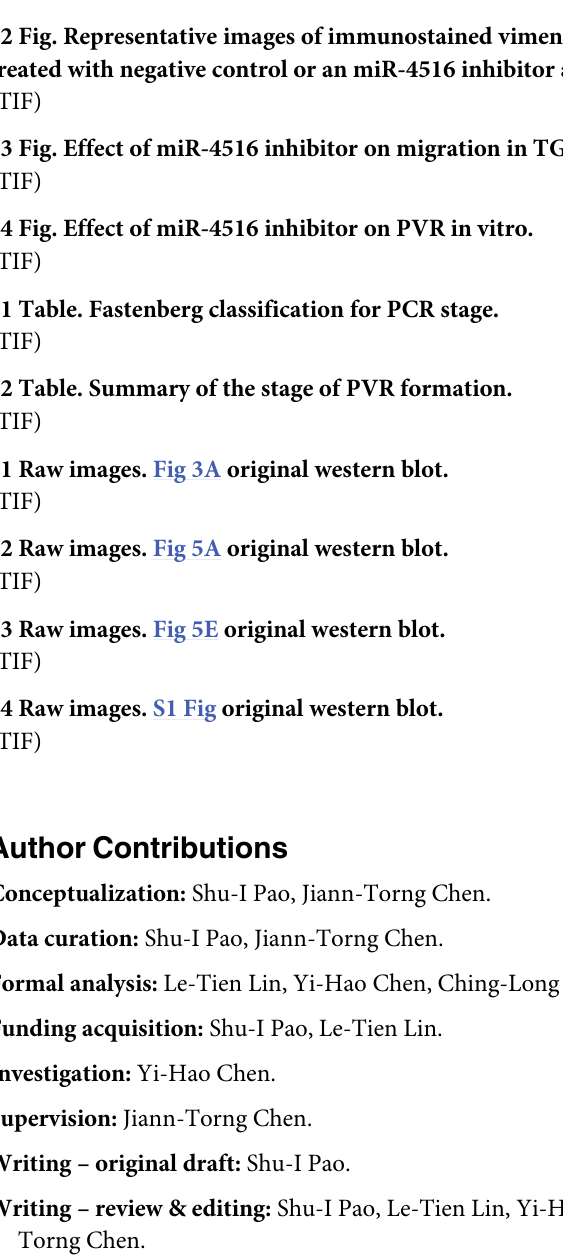
S2 Fig. Representative images of immunostained vimentin and ZO-1 in ARPE-19 cells treated with negative control or an miR-4516 inhibitor and treated with TGF- β 2 for 48 h. (TIF) S3 Fig. Effect of miR-4516 inhibitor on migration in TGF- β 2-treated ARPE cells. (TIF) S4 Fig. Effect of miR-4516 inhibitor on PVR in vitro. (TIF) S1 Table. Fastenberg classification for PCR stage. (TIF) S2 Table. Summary of the stage of PVR formation. (TIF) S1 Raw images. Fig 3A original western blot. (TIF) S2 Raw images. Fig 5A original western blot. (TIF) S3 Raw images. Fig 5E original western blot. (TIF) S4 Raw images. S1 Fig original western blot.